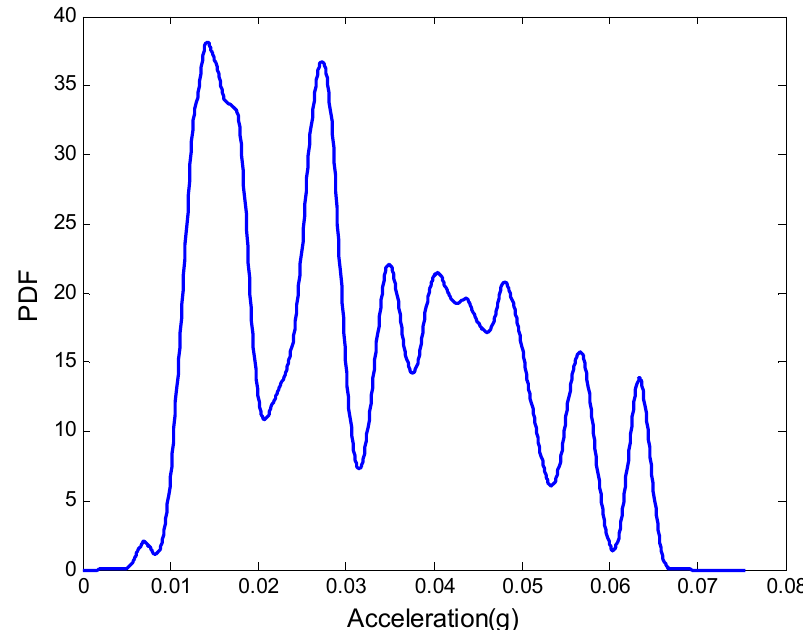
Figure 6. PDF of an equivalent extreme value event of floor acceleration.